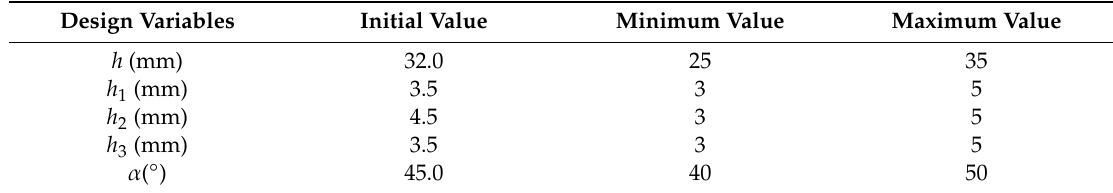
Table 2. Variation range and initial value of design variables.